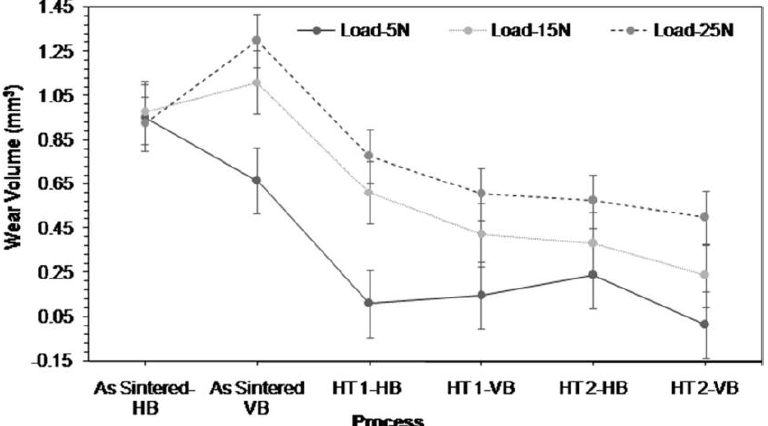
Figure 17. Wear volume of assintered and heat-treated specimens. Reproduced from [58], with permission from Springer Nature, 2017.